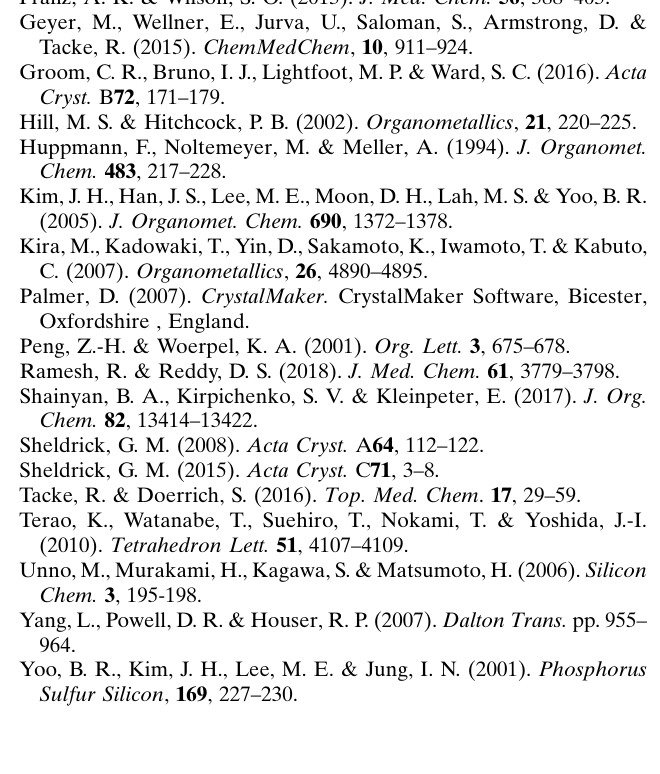
Crystal data Chemical